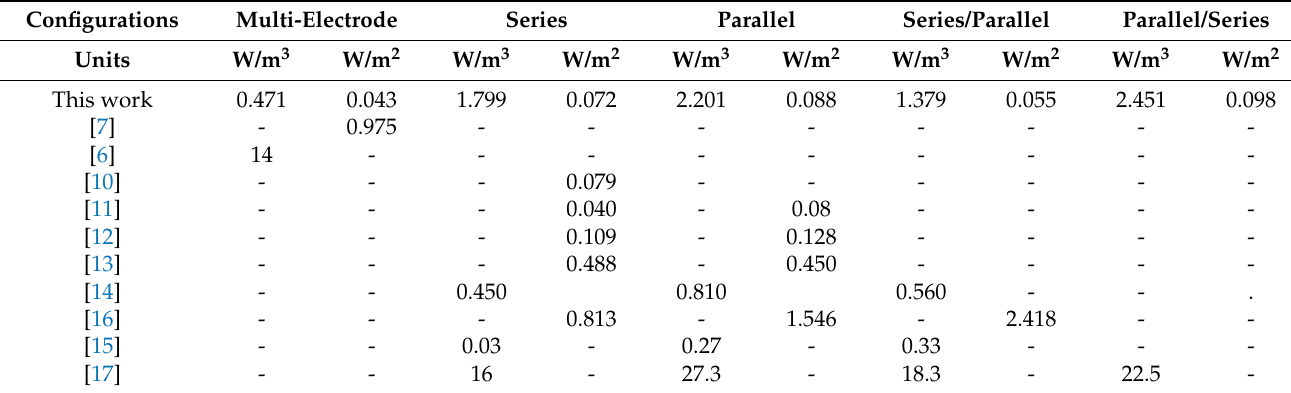
Table 7. Comparison of the performances with literature